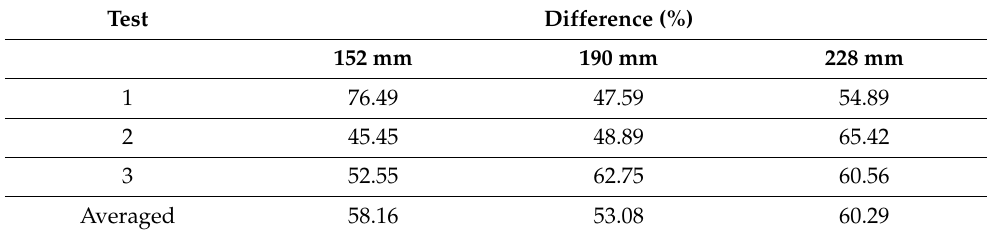
Table 1. Difference of E-index (relative to 0 s) for each length